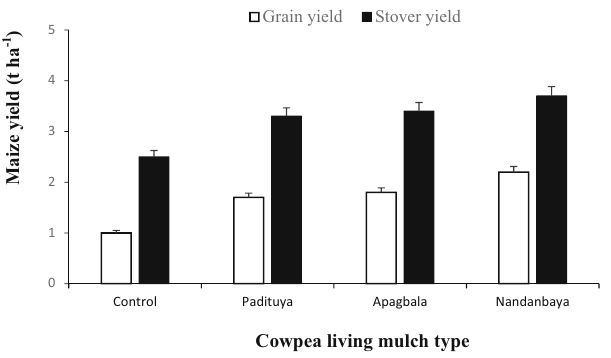
Figure 4: The e ff ect of cowpea living mulch types on maize grain and stover yield ( average of the two maize varieties and the cropping season ) . Bars represent standard error